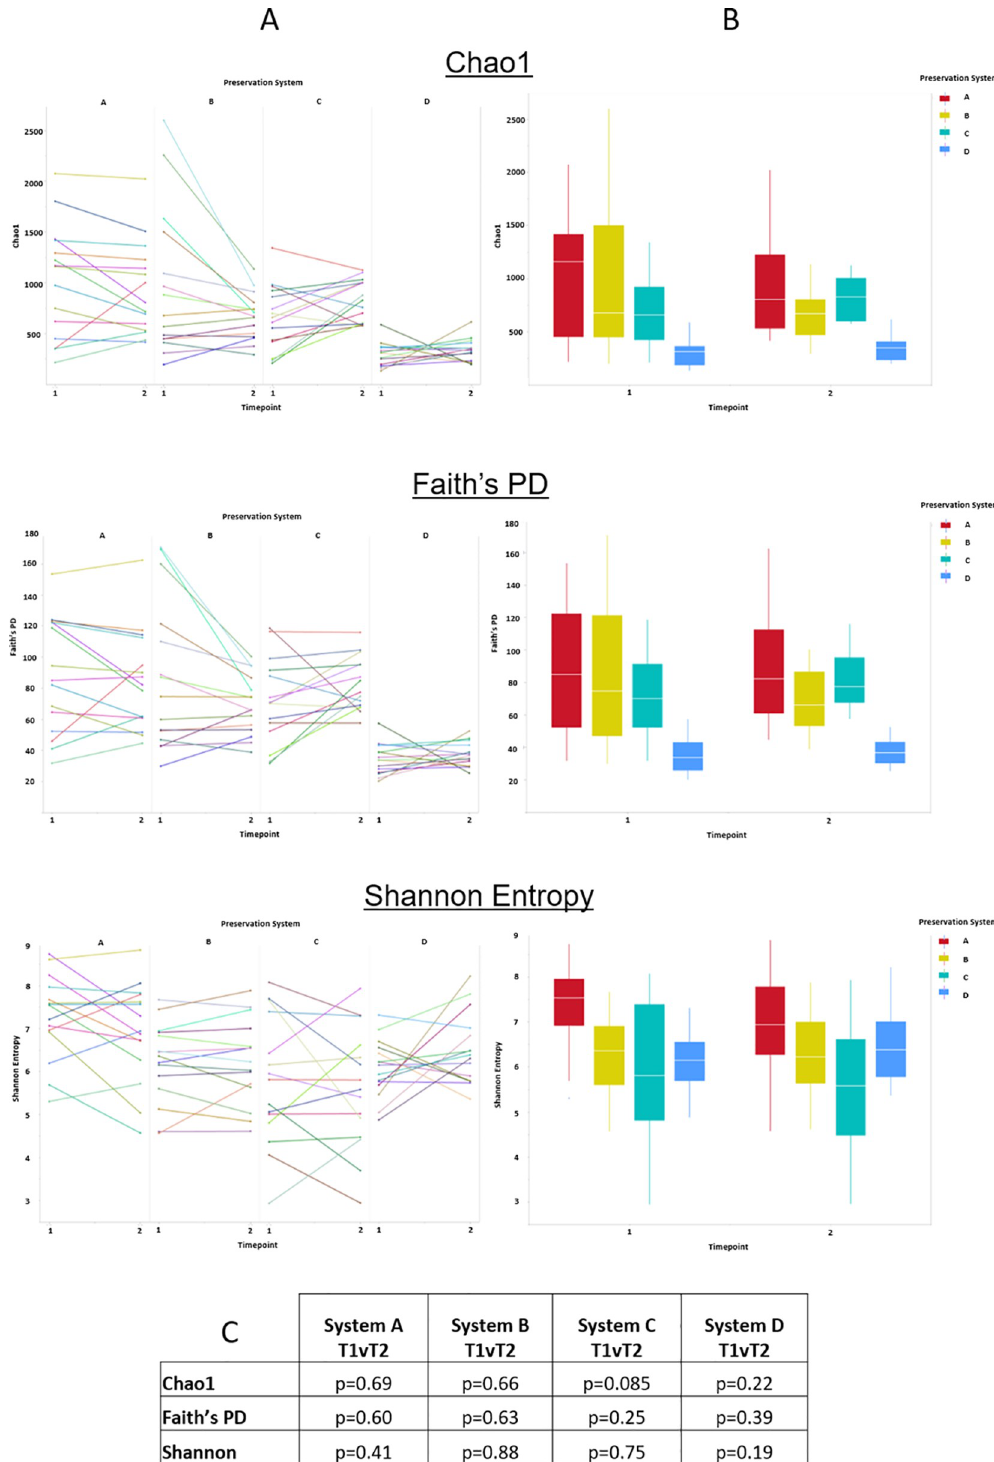
Fig 2. Alpha diversity analysis of leg skin microbiome before and after formulation application. A, Per sample alpha diversity assessment of the impact of the different preservation systems on the skin microbiome. B, Group alpha diversity assessment of the impact of the different preservation systems on the skin microbiome. C, Statistical analysis of alpha diversity changes between timepoints for each preservation system.